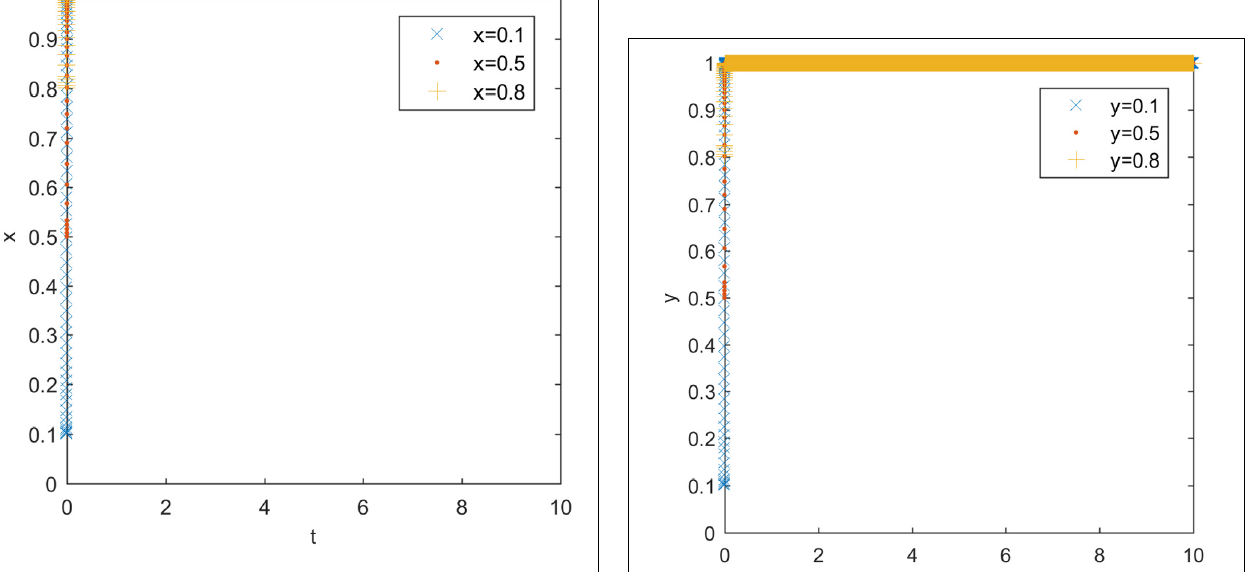
FIGURE 2 | G e − E < P traditional energy enterprises’ evolutionarily stable strategy.